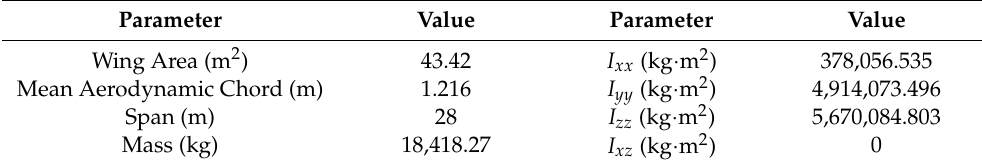
Table 3. Chaka-50 required specifics for